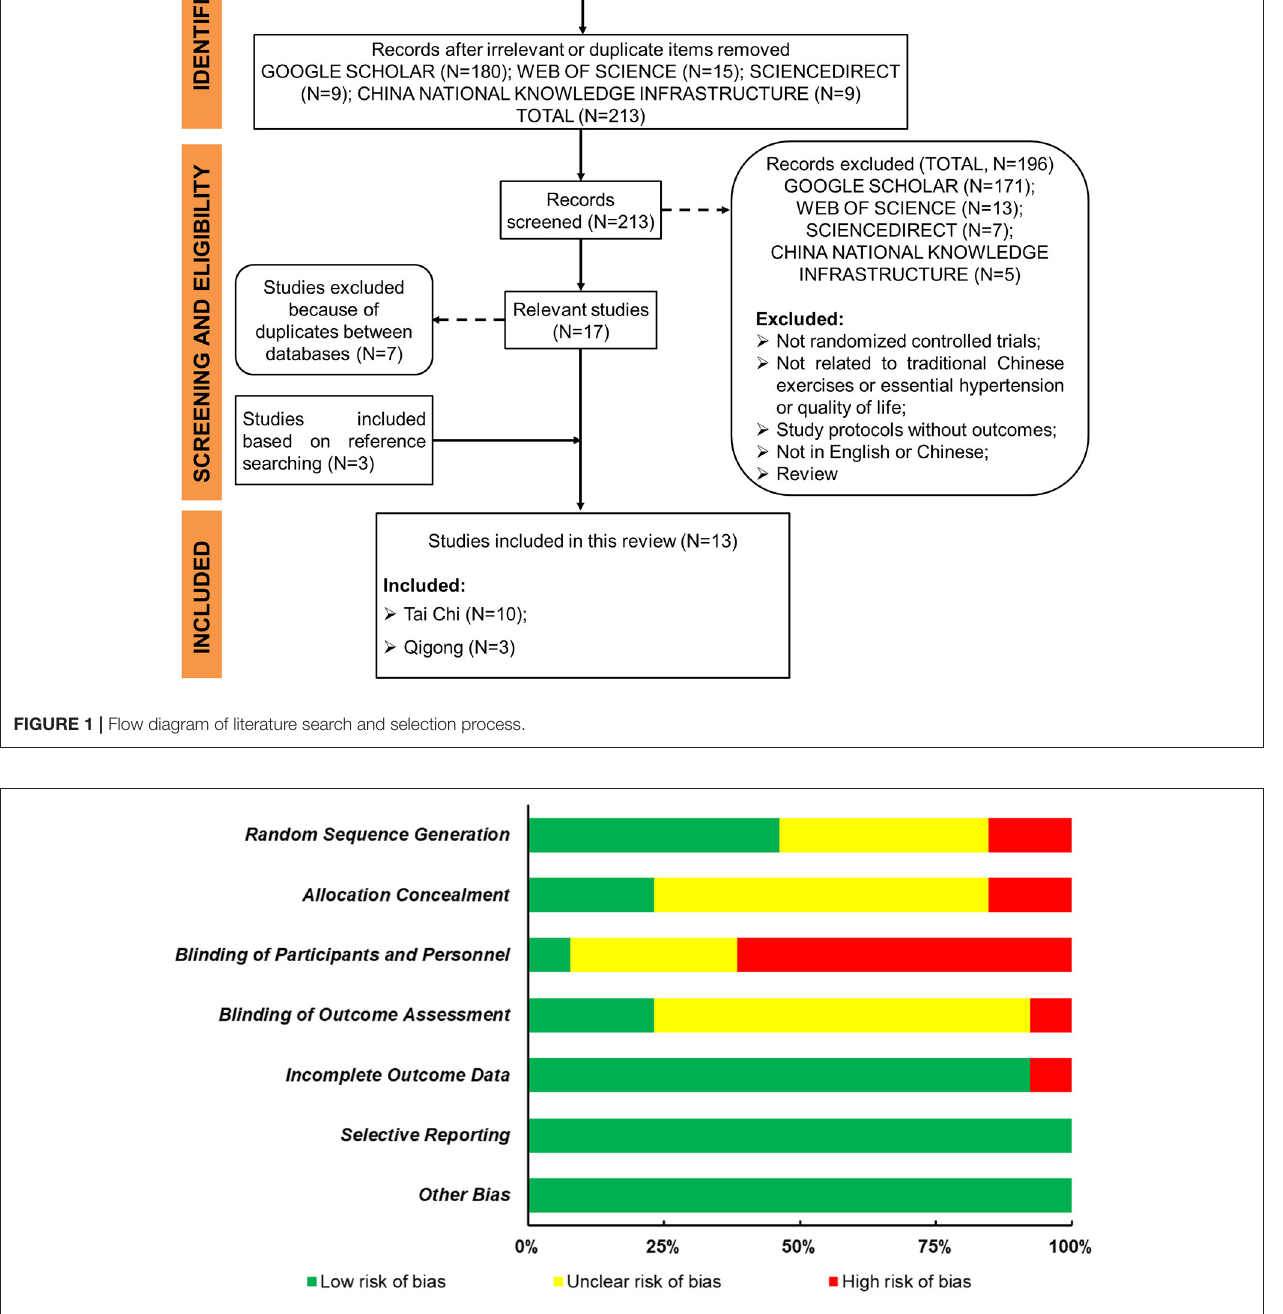
FIGURE 2 | Risk of bias